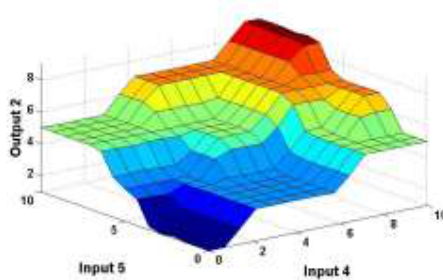
Figure 12. Surfaces of the fuzzy logic subsystem 2.